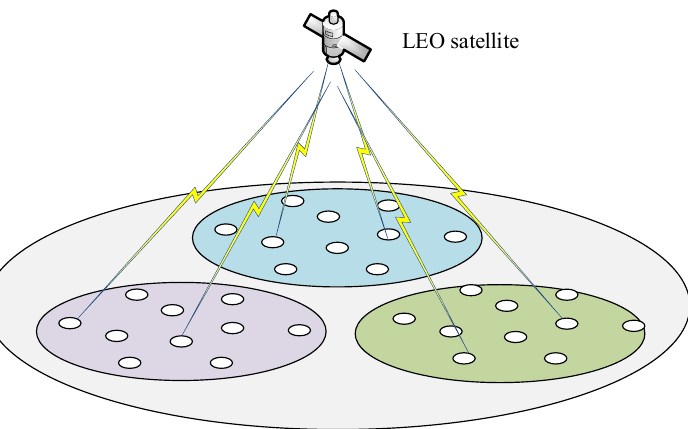
Figure 1. Satellite IoT scenario model with sink nodes.